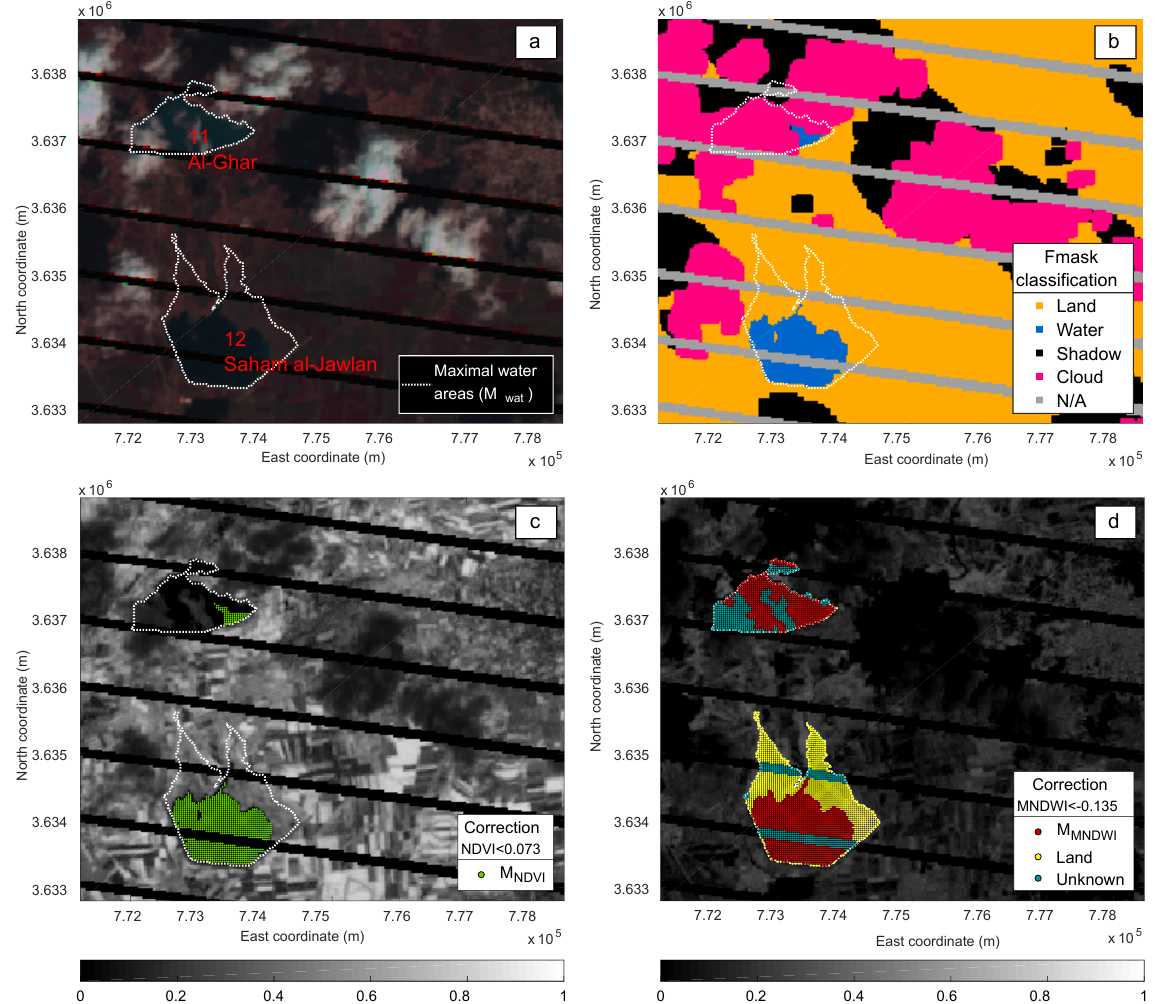
Figure 4. Two-dimensional dynamic water classification over a part of a Landsat 7 image (174/37) obtained on 30 March 2010. Coordinates are expressed in CRS WGS 84/UTM zone 36N. (a) SWIR-R-G image. Two reservoirs can be seen by eye – even if their appearance is very similar to cloud shadow areas – but the hedges are not easy to detect due to the cloud cover. (b) Results of the Fmask classification. Water area detection is not precise enough to directly use the results for the estimation of reservoir surface area. (c) NDVI image. Water pixels’ low NDVI here contrasts with the surrounding irrigated crops’ high NDVI, as the two reservoirs are located close to cultivation areas. (d) MNDWI image. Red dots indicate water areas obtained after the 2-D enhancement (Sect. 2.1). The 3-D reconstruction is done later (Sect. 2.3) on the Unknown